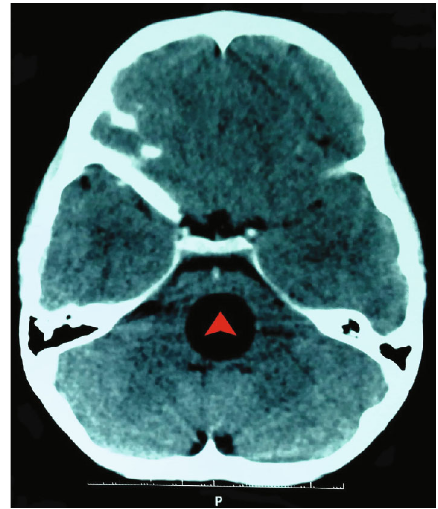
Figure 2: Enhanced CT scan shows a well-de fi ned, thin-walled, round cyst in the pons (red arrowhead). No calci fi cation, surrounding edema, or contrast enhancement is